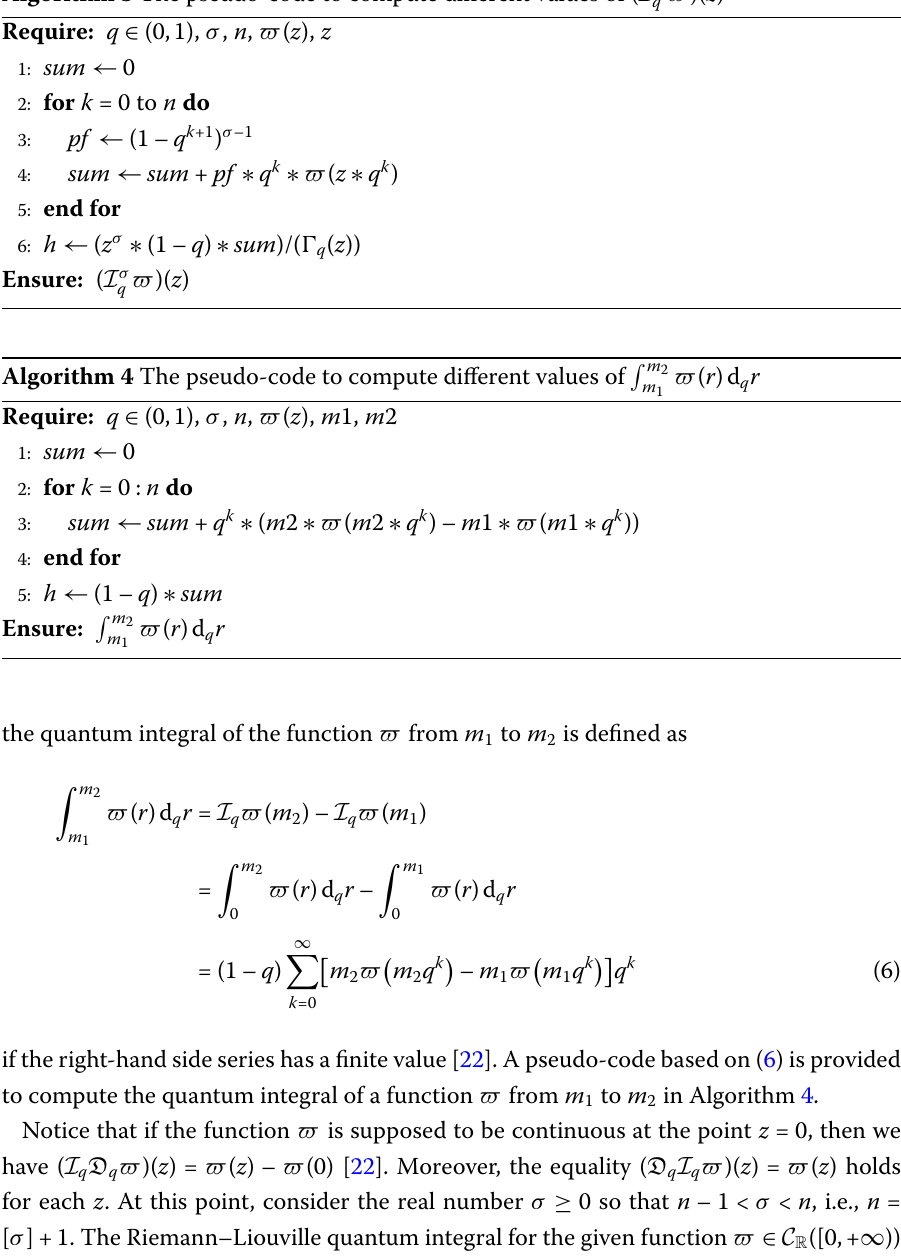
Algorithm 3 The pseudo-code to compute different values of ( I σ